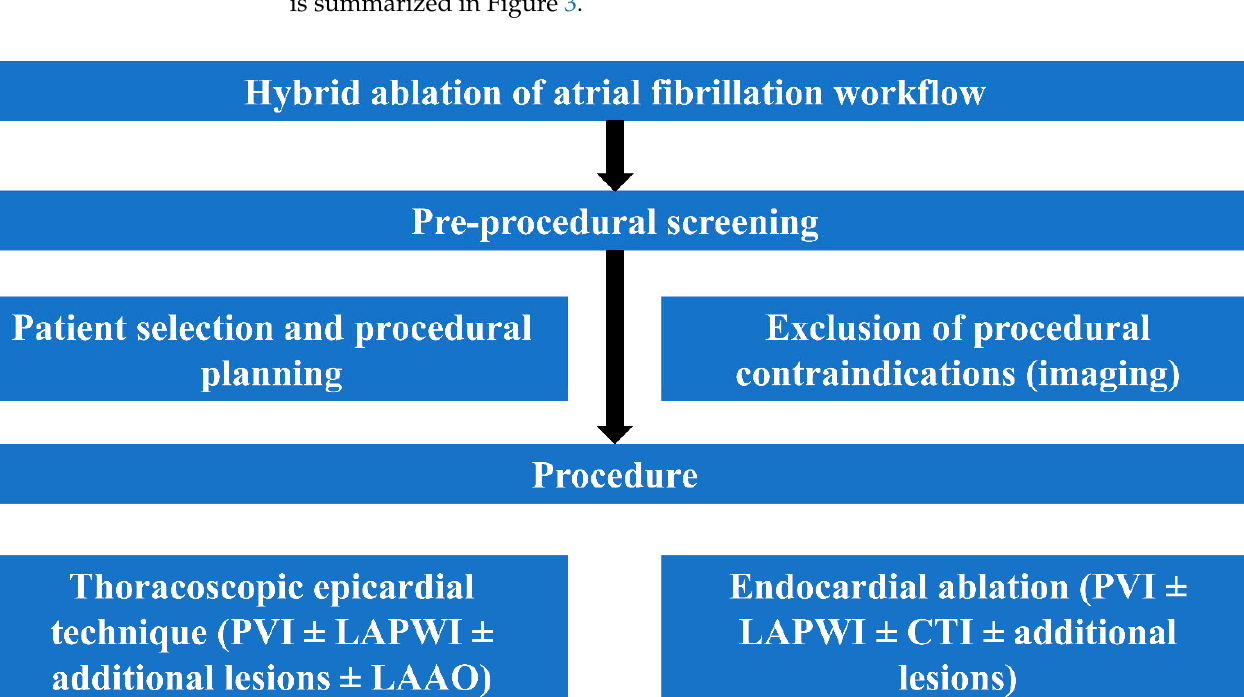
Table 1. Summary of studies on hybrid atrial fibrillation ablation.